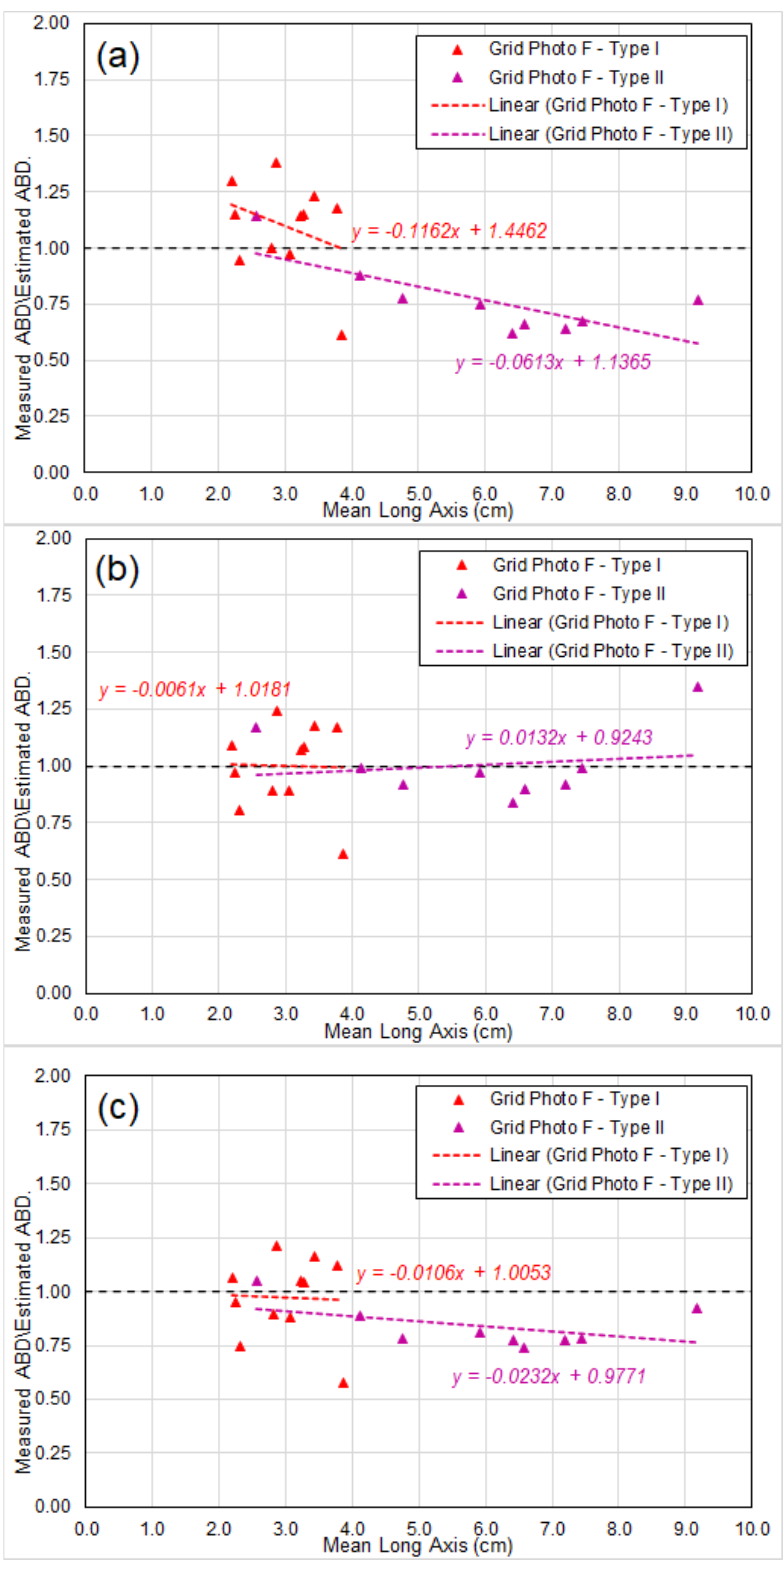
Figure 11. Comparisons of the measured Abundances and the predicted ones by the new empirical method with Dataset 2: ( a ) by empirical formula Equation (19); ( b ) by empirical formula Equation (19) with a linear adjustment; ( c ) by empirical formula Equation (25).